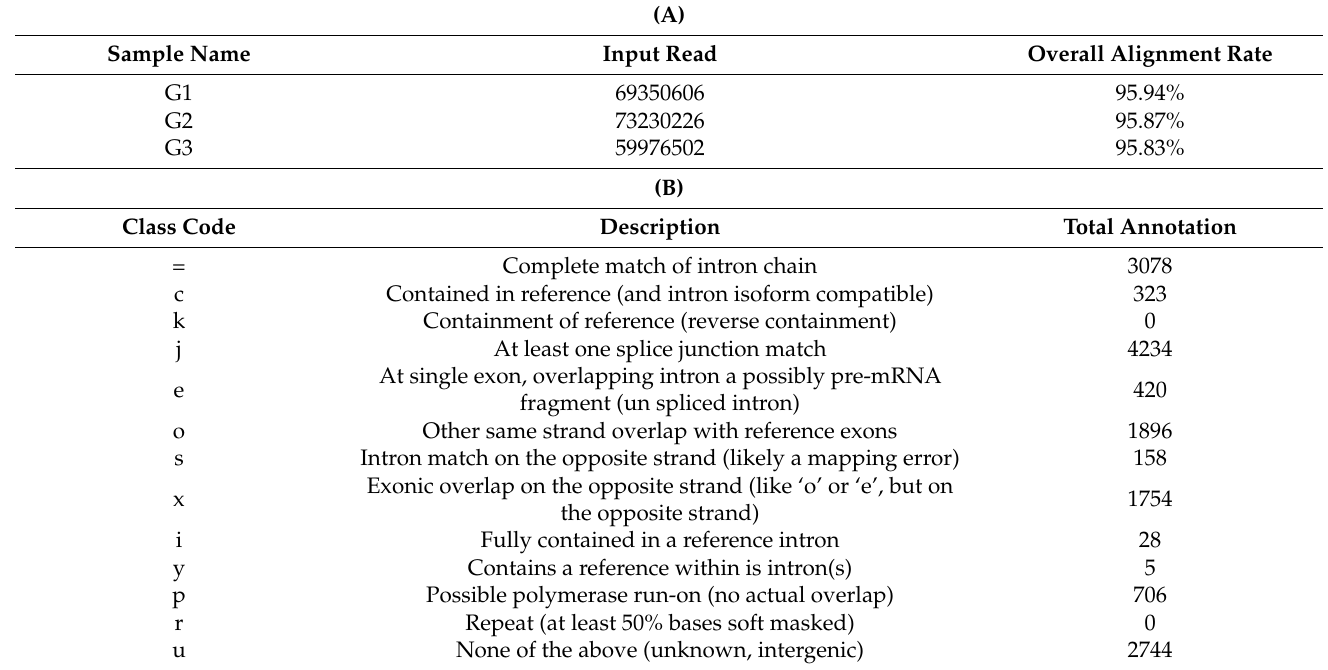
Table A1. ( A ): RNA-seq data alignment results for reads of different samples. ( B ): Different classes of assembled transcripts.